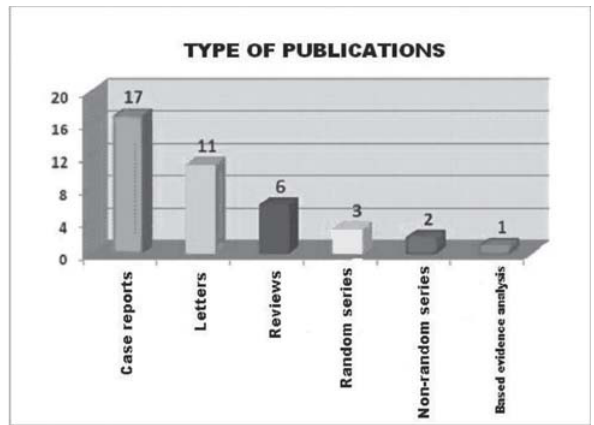
Fig. 4 - Types of publications. Random series = series of randomized patients; series non-radom = series of patients not randomized; Bas study. Eviden. = Based evidenced